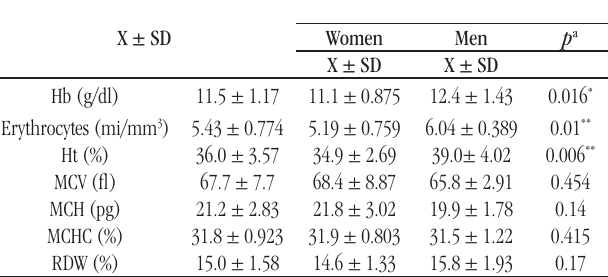
taBLE 1 − General characteristics of study participants X ±